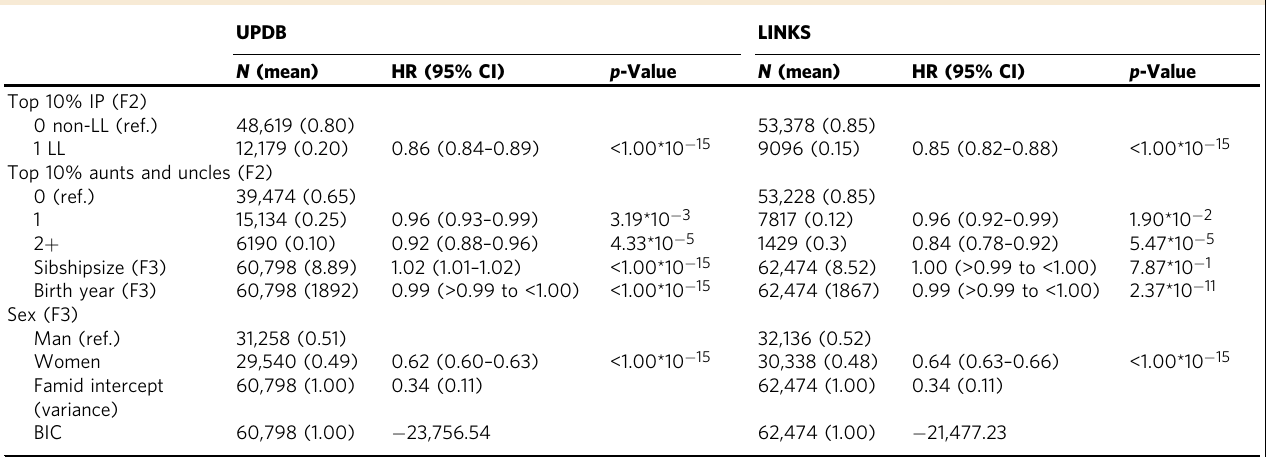
Table 3 Frailty survival analysis for children of IP ’ s with top 10% IPs and aunts and uncles